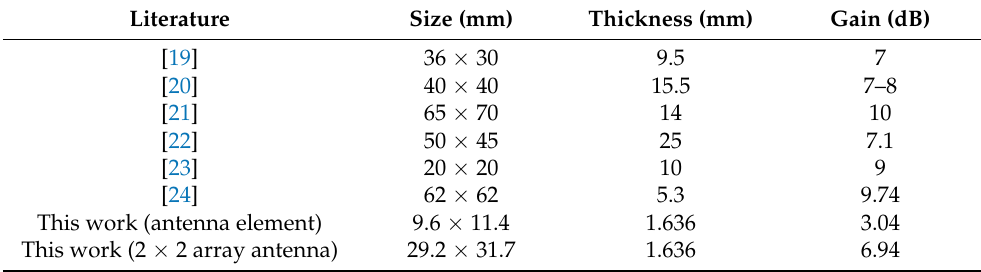
Table 1. Proposed and other circularly polarized UWB antennas reported in the literature.